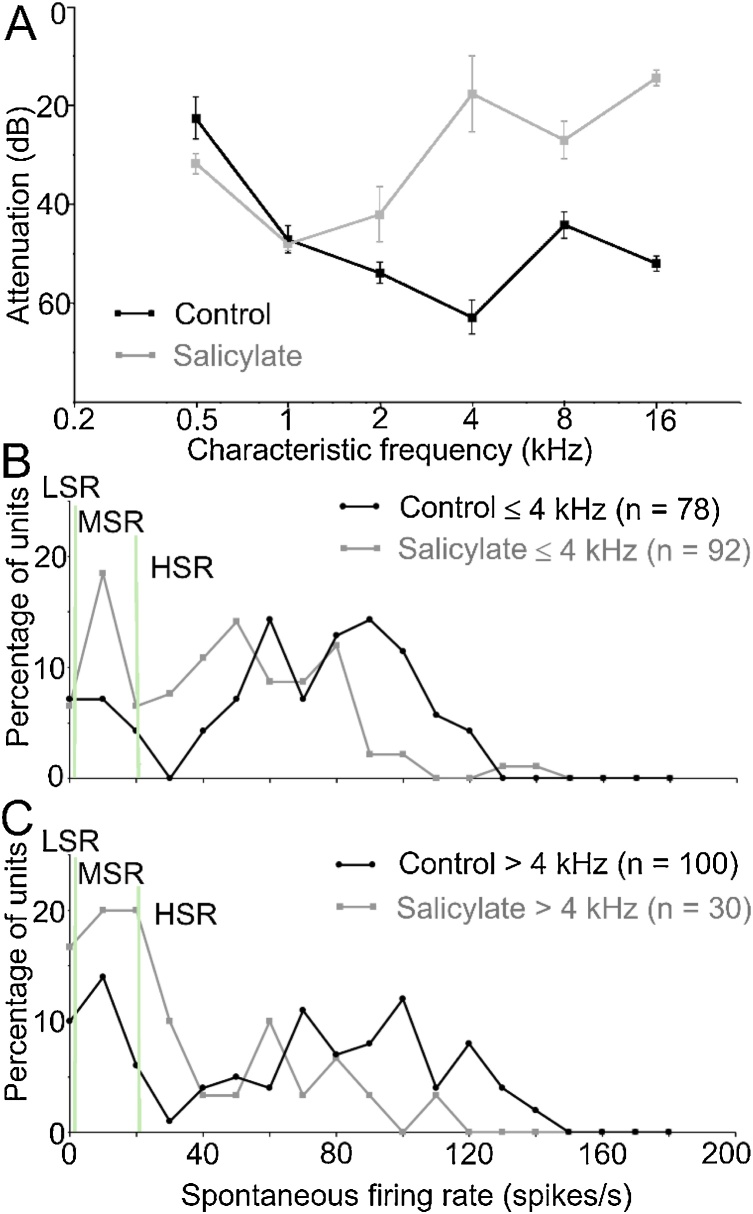
(A) Plots showing the mean threshold (± standard error) for the recorded units in the two populations using octave bands starting with all units with CFs ≤ 0.5 kHz. (B) Plots showing the percentage of units with a particular spontaneous rate in the same sequence of bins, as shown in Fig. 1D, for the two populations with low CFs. (C) Plots showing the same data for the populations with high CFs. In each case the pale green vertical lines mark the borders between the fibre subtypes.